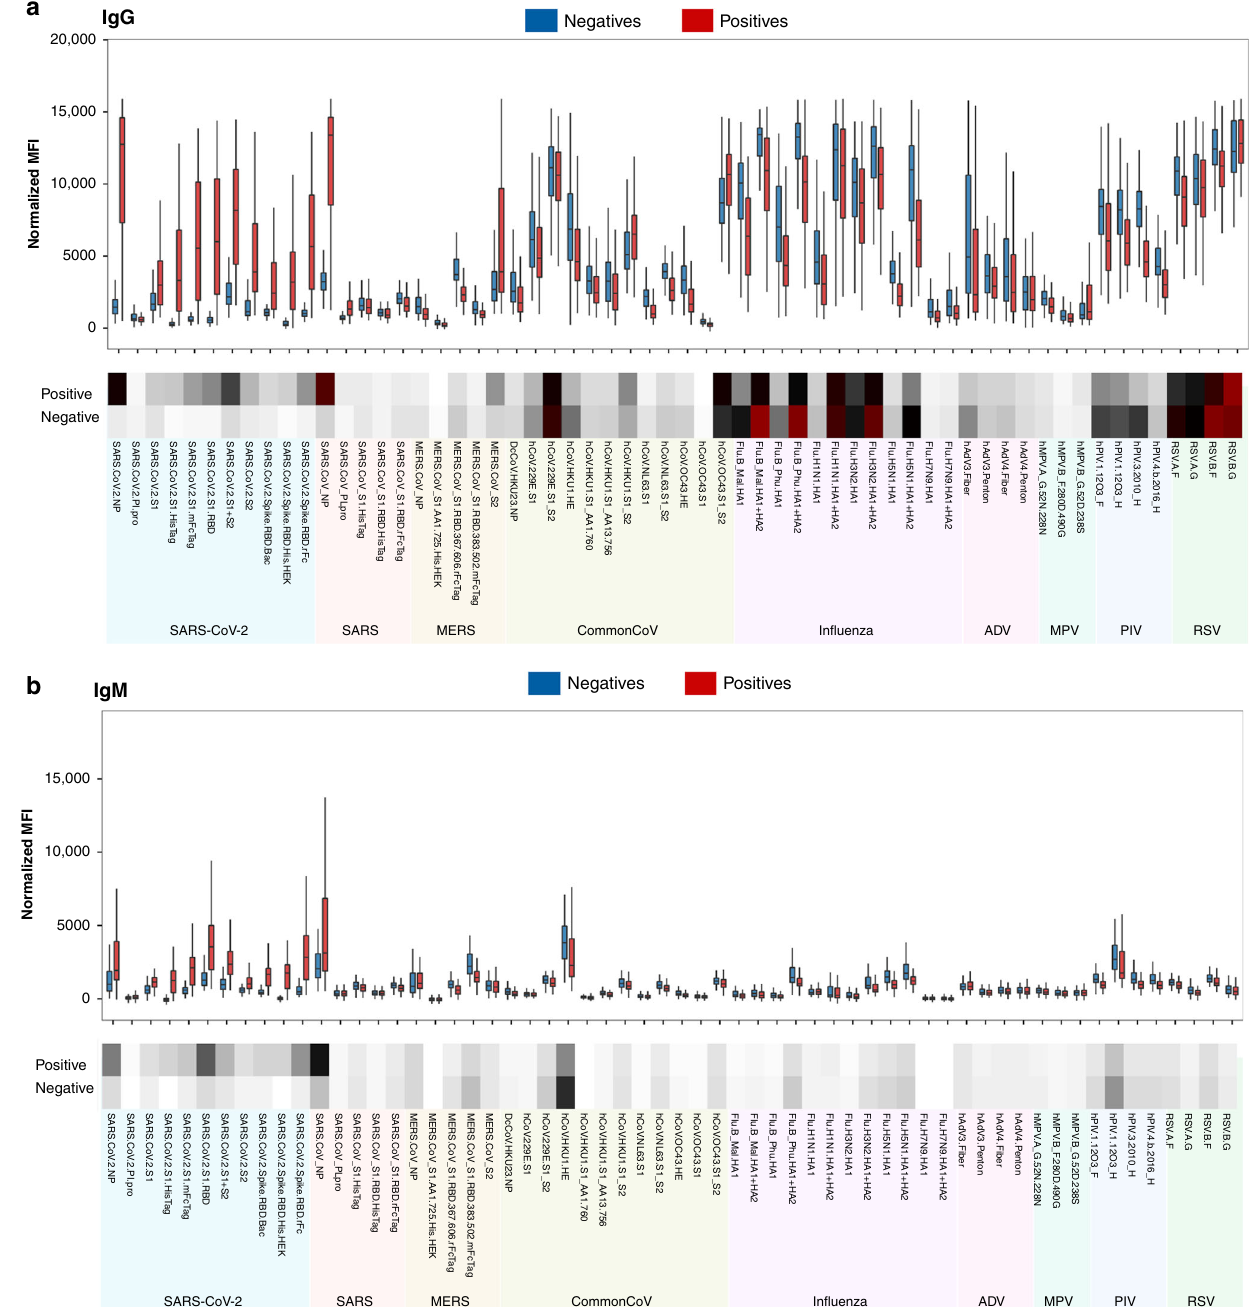
Fig. 2 Normalized antibody reactivity of positive and negative sera on coronavirus antigen microarray. The plot shows IgG ( a ) and IgM ( b ) reactivity against each antigen measured as mean fl uorescence intensity (MFI). The boxes represent the fi rst quartile, median and third quartile and the whiskers extend 1.5 times the interquartile range (IQR). Each point represents the distribution of the reactivity for either convalescent blood specimens from PCR- positive individuals (positive, red, n = 100) and sera from naive individuals prior to pandemic (negative, blue, n = 88). Below the plot, the heatmap shows average reactivity for each group (white = low, black = mid, red = high). The antigen labels are color coded for respiratory virus group. Source data are provided as a Source data fi